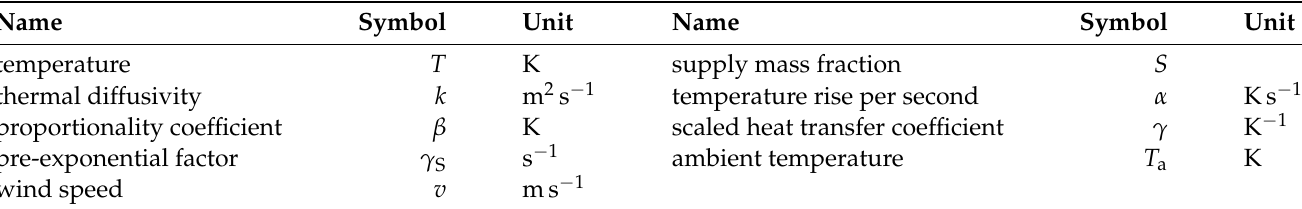
Table 1. Variables in the wildland fire